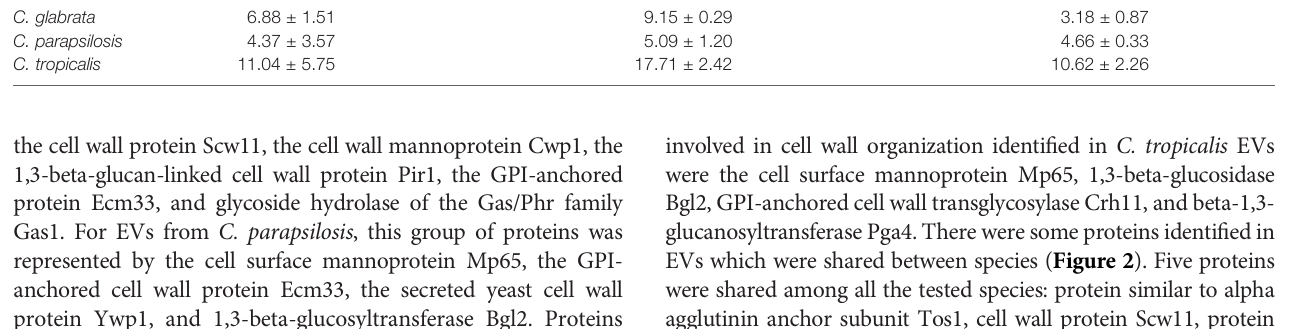
TABLE 1 | Average protein, lipid, and carbohydrate contents in EVs released by Candida glabrata , Candida parapsilosis , and Candida tropicalis bio fi lms. Protein content (micrograms per 1 × 10 10 vesicles)